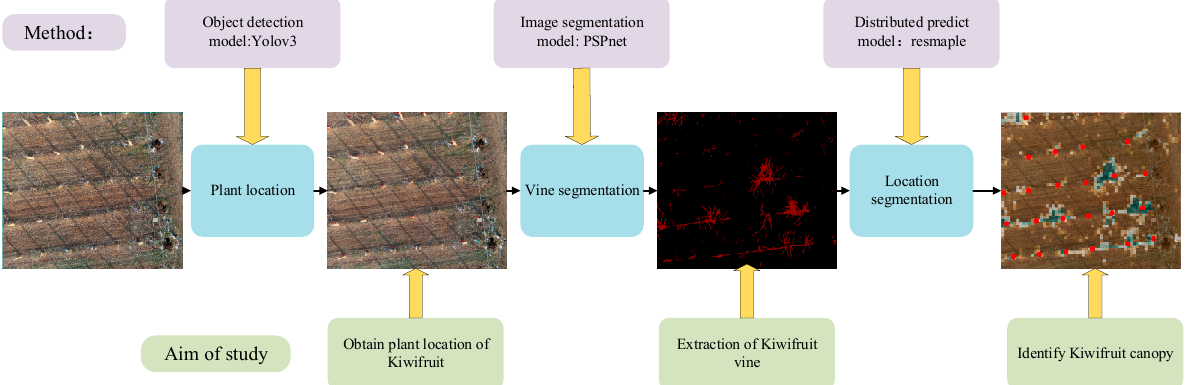
Figure 2. Flowchart of the kiwifruit location and distribution prediction. The orchard image is used to recognize a single tree. The vine is separated from the background through image segmentation to prepare for the next step of predicting the distribution. A two-dimensional map with plant location and canopy distribution information is formed.